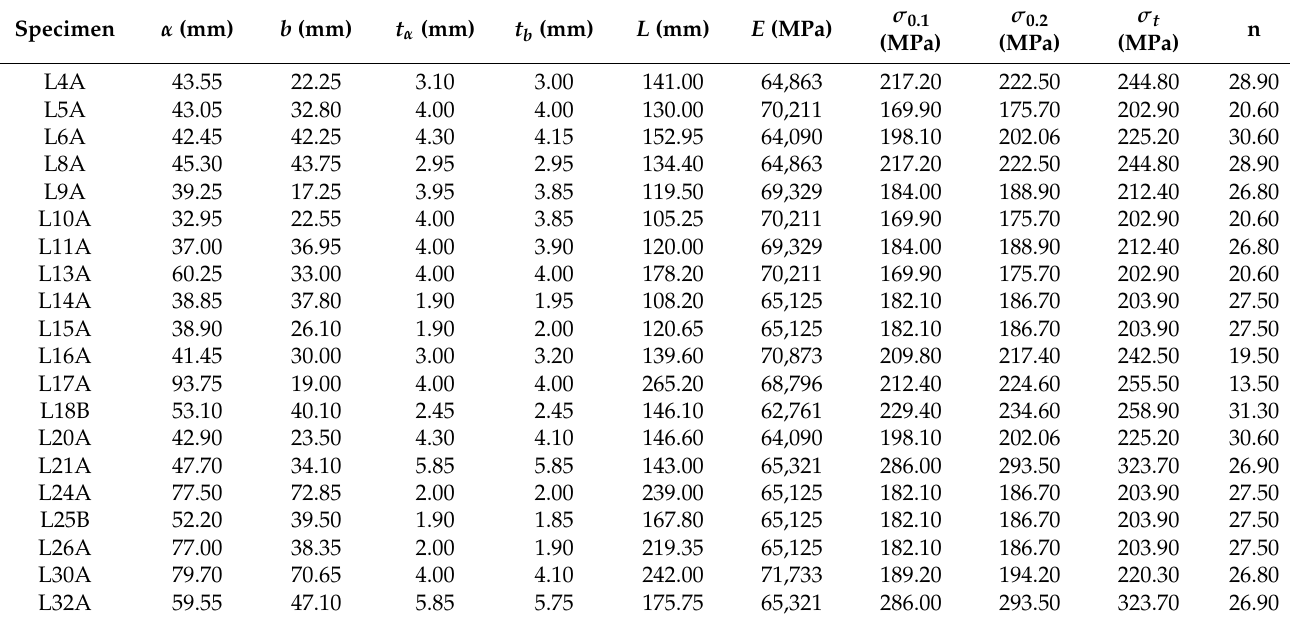
Table 1. Summary of reported results for angle section stub columns [3].